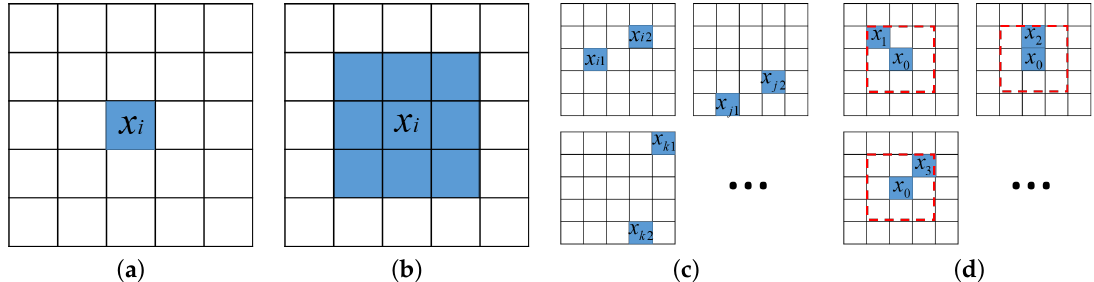
Figure 1. Illustrations of popular features used in HSI classification. Early CNN-based HSI classification methods are either based on raw spectral pixel feature [22] in ( a ) or spectral pixel patch feature [37] in ( b ). As shown in ( c ), [32] adopts a random sampling scheme across the entire training set to construct a large number of labeled pixel pair features (PPF) pairs. The proposed spatial pixel pair feature (SPPF) feature chooses a tight eight-neighbor as N ( x 0 ) , from which SPPF pairs are built, such as } , { x { x } , etc. ( a ) Raw spectral pixel feature; ( b ) spectral pixel patch feature; ( c ) PPF feature; 0 , x 1 0 , x 2 ( d ) proposed SPPF